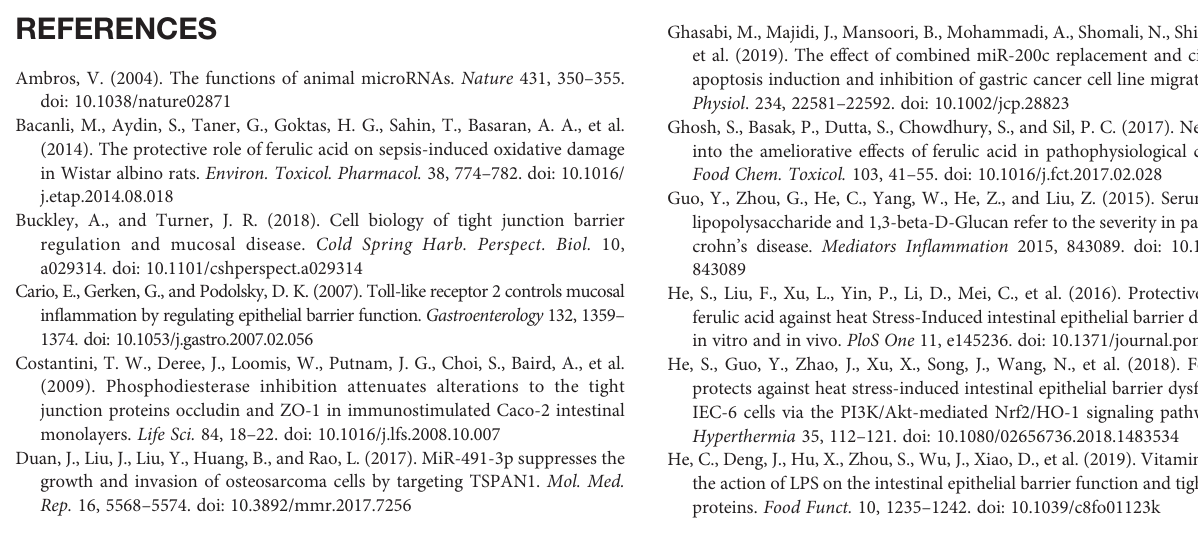
TABLE S1 | List of differentially expressed miRNAs in Caco2 cells of FA pretreatment compared with the LPS treatment without FA. FIGURE S1 | The effect of miR-491-3p in FA protection against LPS-induced intestinal epithelial barrier dysfunction. Caco-2 cells were transfected with Lv-miR- 491-3p and Lv-miR-491-3p spong at an MOI of 20 and incubated for 48 h at 37°C with 5% CO2. The protein expression levels of occludin and ZO-1 were determined by Western blot analysis. FIGURE S2 | FA activated PI3K/AKT pathway in Caco-2 cells. Caco-2 cells were treated with 100 m M FA for 2 h. The expression levels of PI3K, p-PI3K, AKT, and p- AKT were evaluated using Western blotting. Data were presented as means ± SD from three independent experiments and differences between means were compared using the unpaired t test. **P<